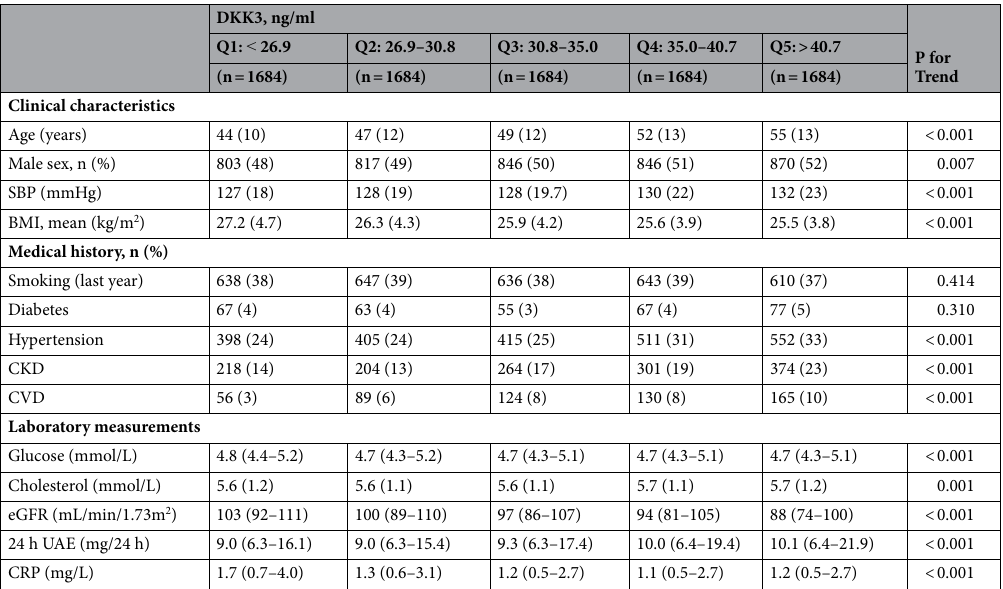
Table 1. Baseline characteristics according to DKK3 quintiles. Continuous variables are represented as mean ± standard deviation (SD) for normally distributed data and as median (interquartile range, IQR) for non-normally distributed data. Categorical variables are represented as n (%). BMI Body mass index, CKD Chronic kidney disease, CRP C-reactive protein, CVD Cardiovascular disease, DKK3 Dickkopf-3, eGFR